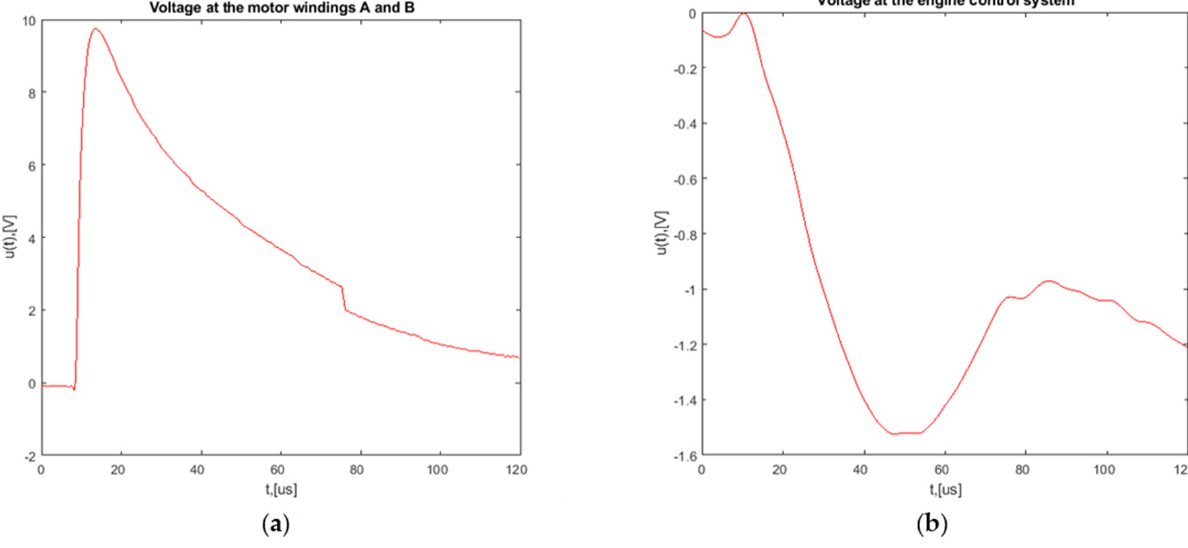
Figure 8. ( a ) Input—Voltage measured at the A and B pins of the first motor windings; ( b ) Output—Voltage measured at the terminals of the engine control